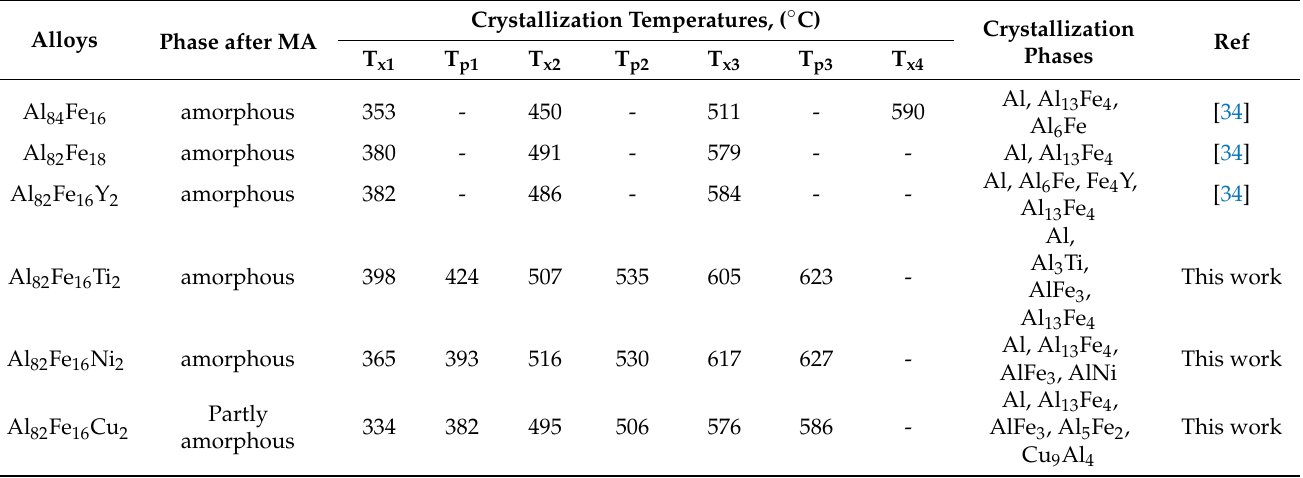
Table 2. Crystallization temperatures and phase compositions of Al-Fe alloys produced by a planetary ball mill. Crystallization Temperatures, ( ◦ Alloys Phase after MA